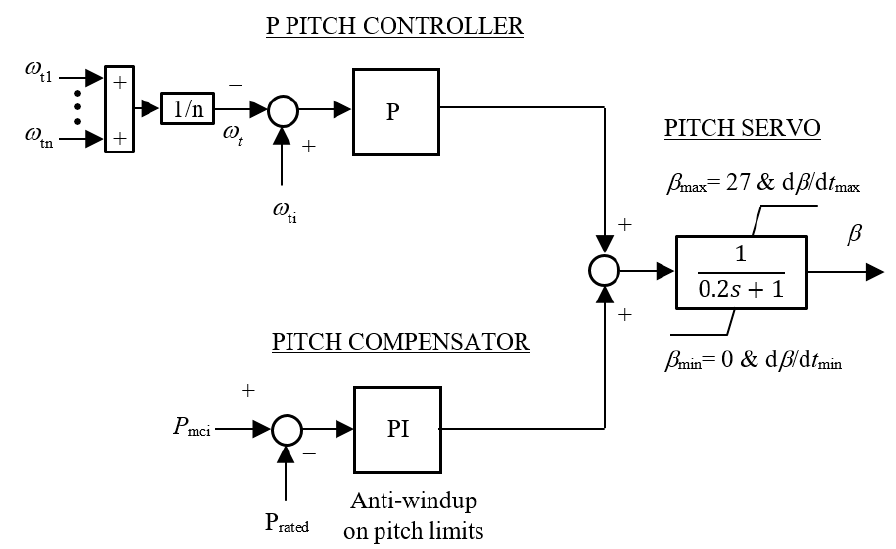
Figure 5. WT pitch control system.